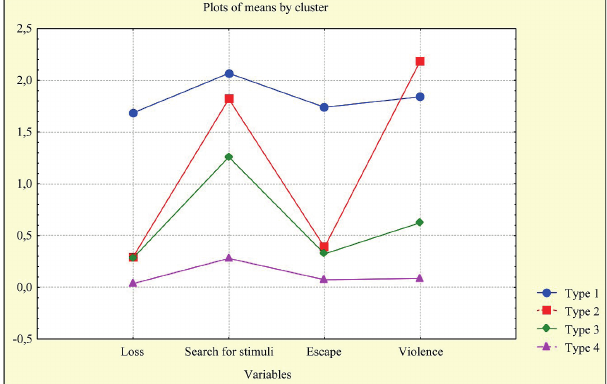
Fig. 1. Mean scores obtained by the four types of gamers on the KBUGI scales: Loss, Entertainment and search for new stimuli, Compensation and escape, Violence and domination